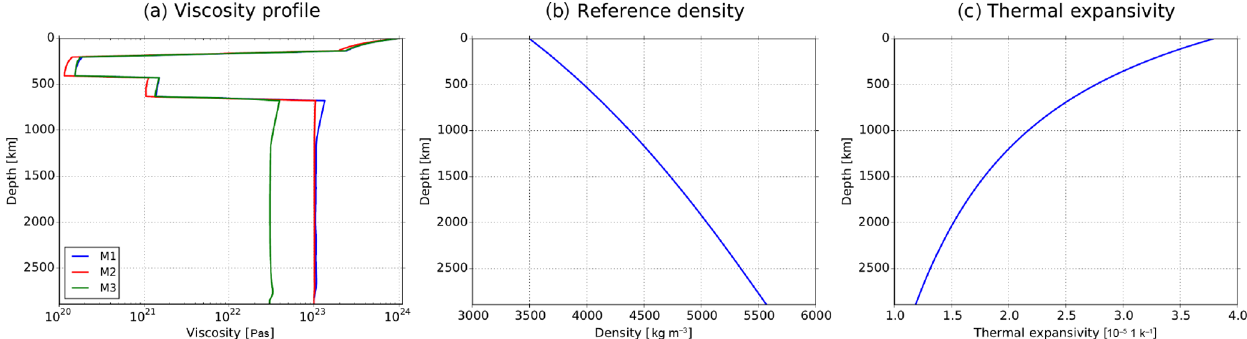
Figure 2. Radial profiles of (a) viscosity, (b) density and (c) thermal expansivity in our models.